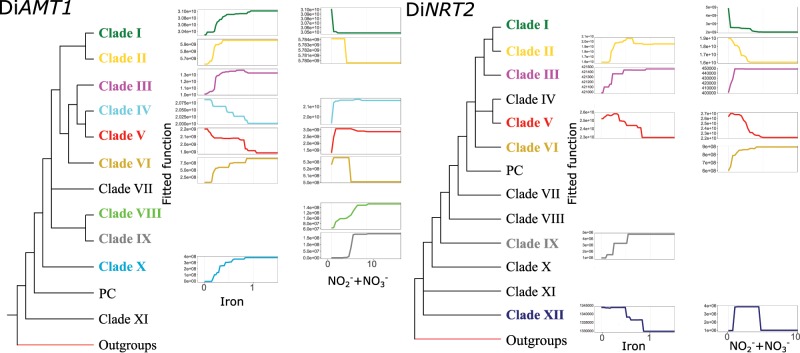
Response curves derived from the BRT models. Herein are showed the univariate response curves from models based on mRNA abundances and only for the two most contributing variables of the models: iron and NO3−+NO2− concentrations. The iron concentrations is expressed in nmol/l while NO2−+NO3− concentration is expressed in µmol/l. Curves are colored as the clades they refer to, depicted on the stylized phylogenetic tree on the left.